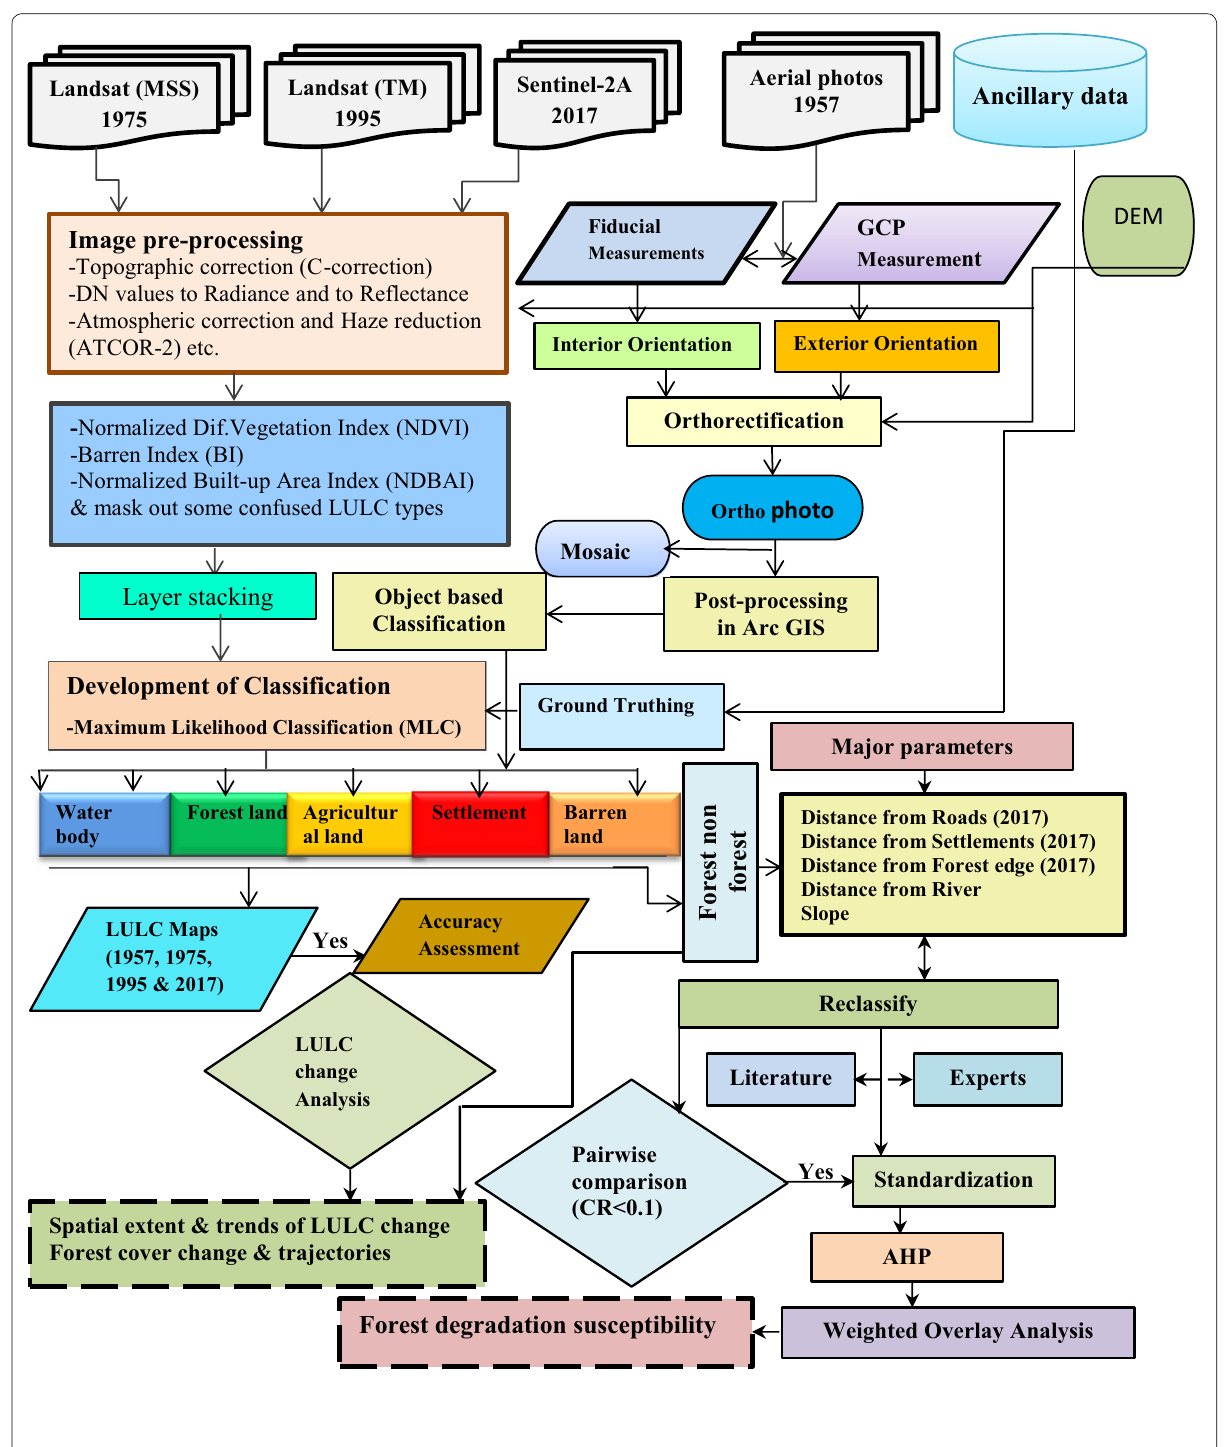
Fig. 3 Methodological flow chart of the